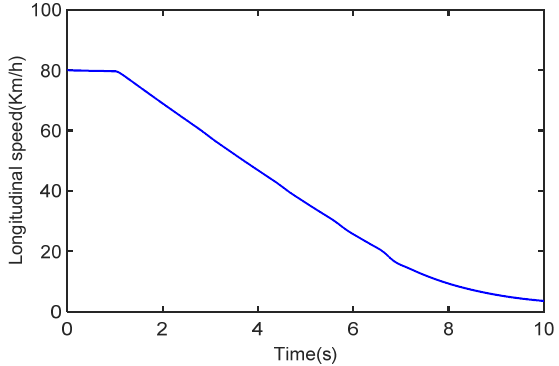
Figure 9. The vehicle speed in the case of deceleration.